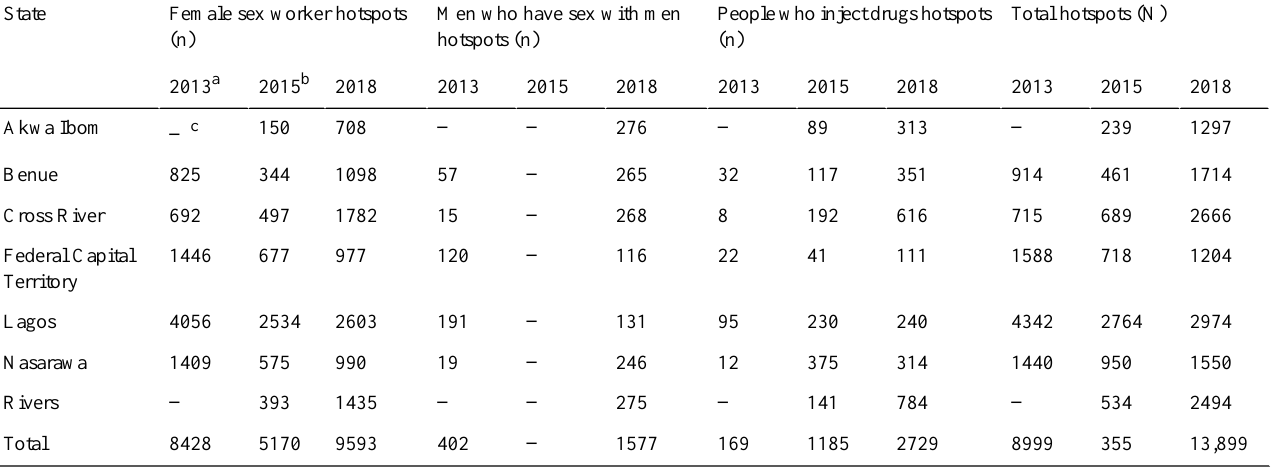
Table 1. Number of hotspots identified in 7 US President’s Emergency Plan for AIDS Relief priority states in Nigeria by key population in 2013, 2015, and